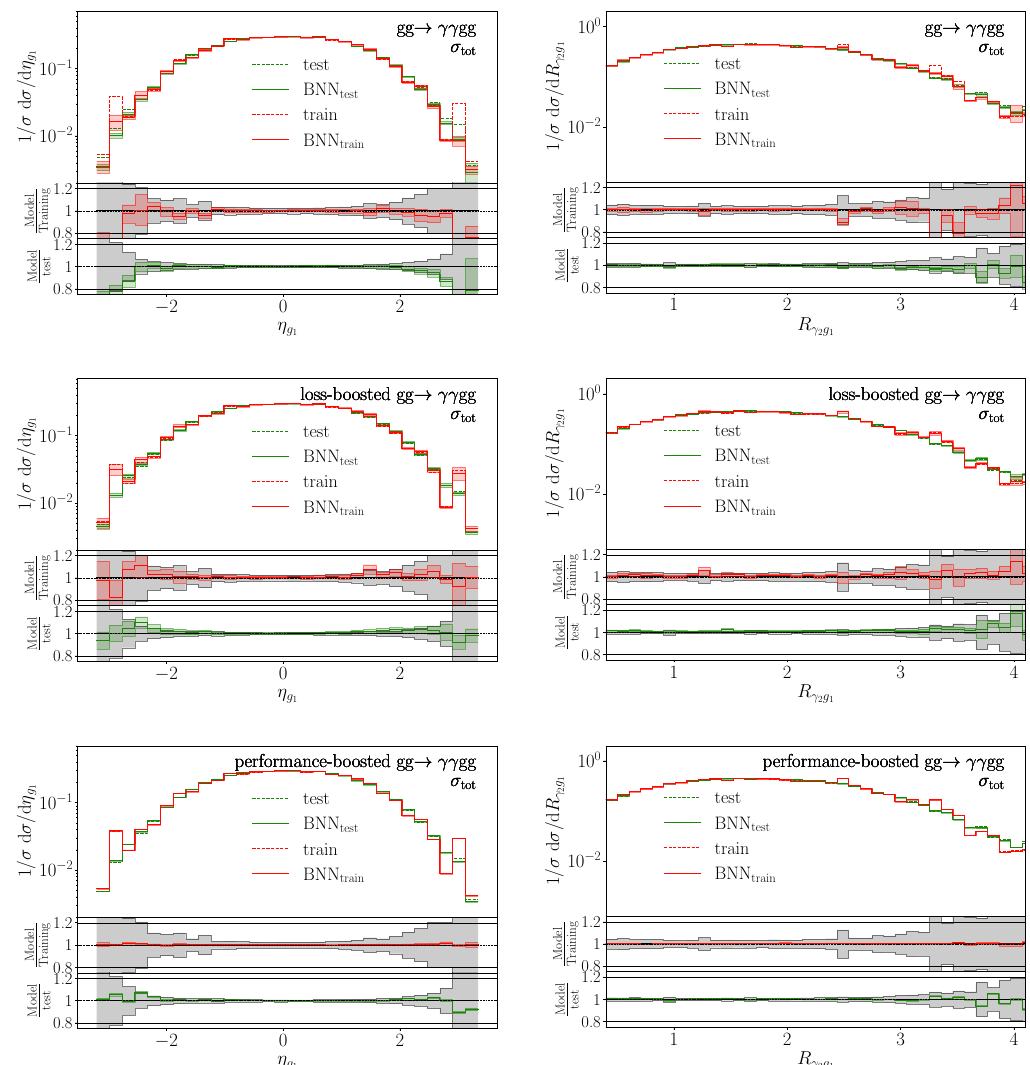
Figure 14: Kinematic distribution for the ( 2 → 4 ) -process without boosting (upper), after loss boosting (center), and after process boosting (lower). The grey error bars in the lower panels indicate the statistical limitation of the training and test